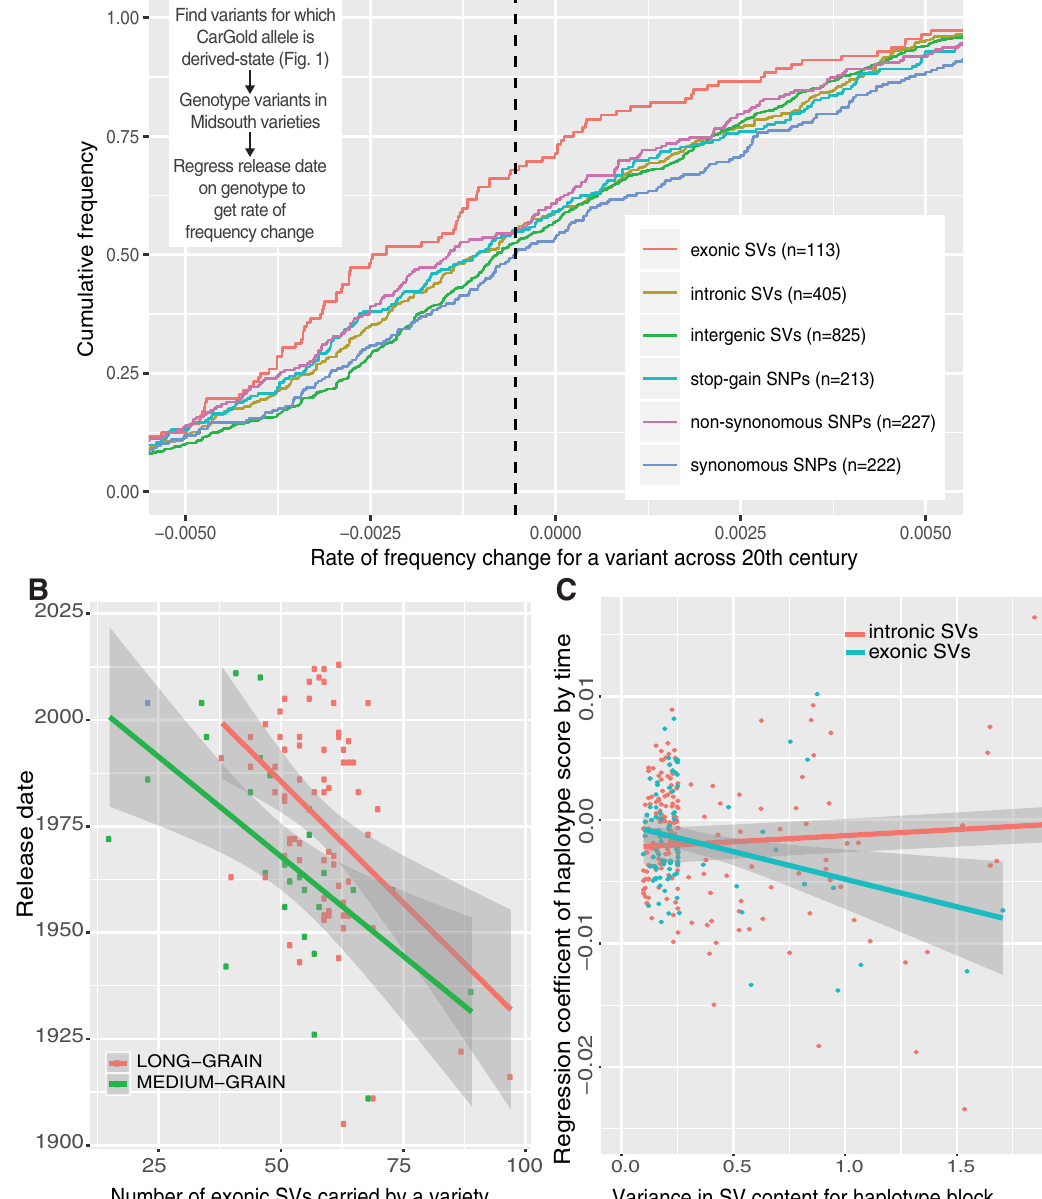
Fig 4. The rate of change in functional variant classes across a century of plant breeding. Rate estimates are reported only for mutations that have occurred in CarGold, not Nipponbare (see Text). A) Cumulative frequency of rates for each variant class. The farther a class is shifted to the left of 0, the more rapidly it has declined on average. B) Plot and linear fit of release date versus the total count of alleles that disrupt an exon in each variety for each grain type. C) Relationship between change in haplotypes scored by number of exonic indels and the variance in this score (see Fig 5). The y-axis represents, for each LD block, the regression coefficient of a linear model between haplotype score and the release date of the variety containing that haplotype. The x-axis represents the variance for those haplotype scores. In B and C, the shading around the regression line represents the 95% confidence intervals in combined intercept and slope